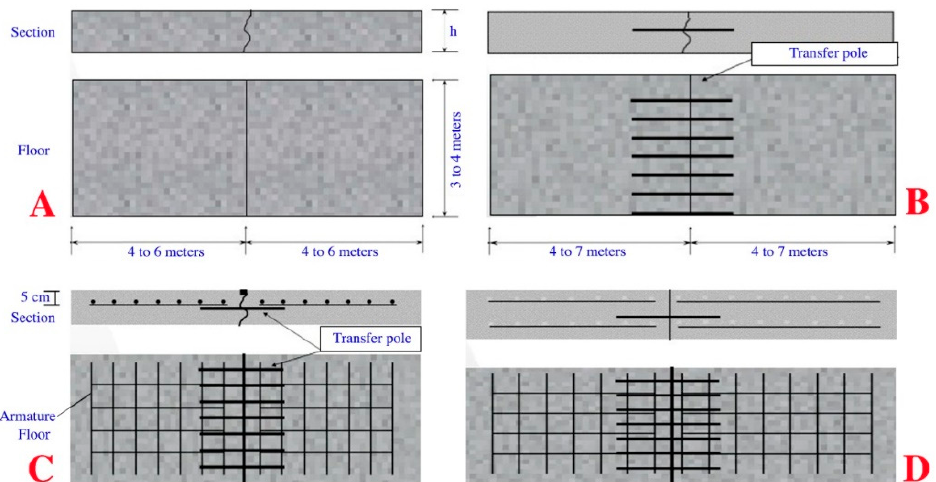
Figure 1. Types of rigid pavements: ( A ) simple concrete pavement; ( B ) simple concrete pavement with transfer pole; ( C ) reinforced concrete pavement with simple continuous distributed reinforcement; ( D ) structurally reinforced concrete pavement. Redesigned and modified from [98] .